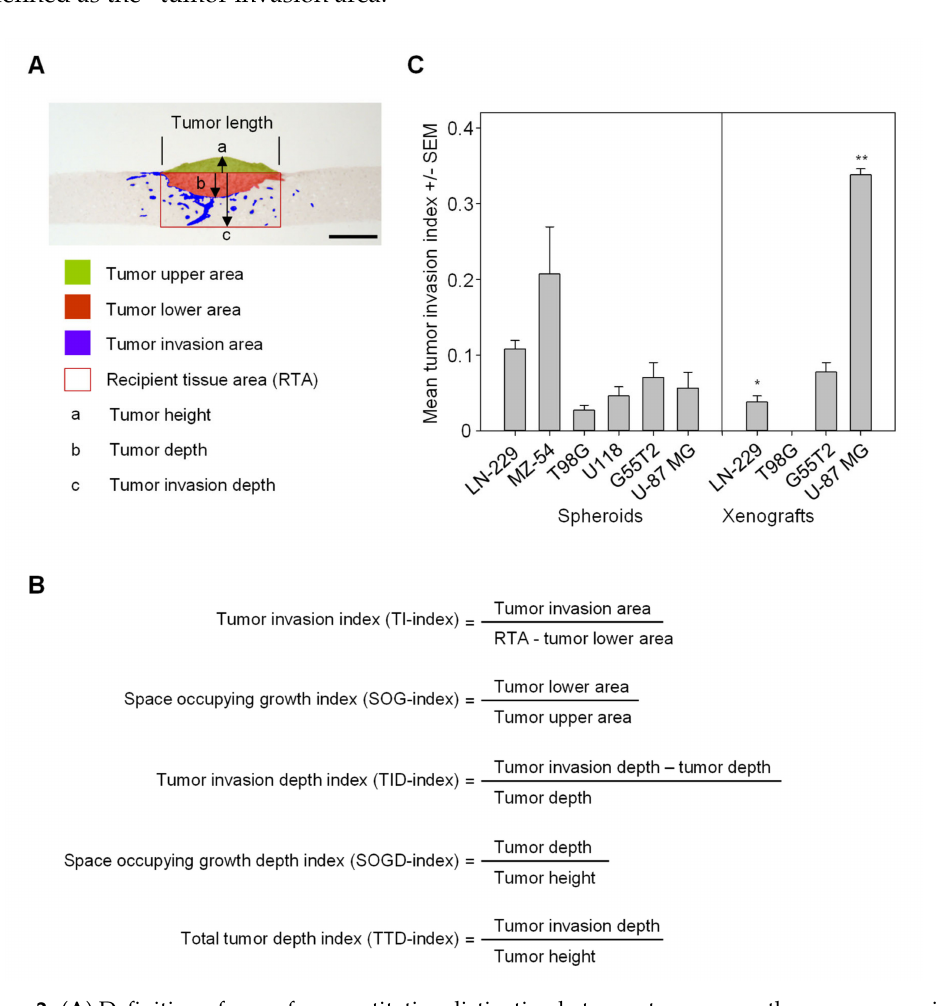
Figure 2. ( A ) Definition of areas for quantitative distinction between tumor growth, space occupying tumor growth (tumor mass e ff ect), and tumor cell invasion. Other parameters (tumor height, tumor depth, tumor invasion depth and recipient tissue area) are shown as well. ( B ) Definition of “tumor invasion index” and “space occupying growth index,” for exact quantitation. Additionally, indices related to tumor depth and tumor invasion depth are defined. ( C ) Tumor invasion index values of spheroid co-cultures and xenograft tandem-cultures, based on di ff erent cell lines. Asterisks indicate statistically significant (* = p < 0.05, ** = p < 0.01) di ff erences of xenograft tandem-cultures vs. their spheroid co-culture